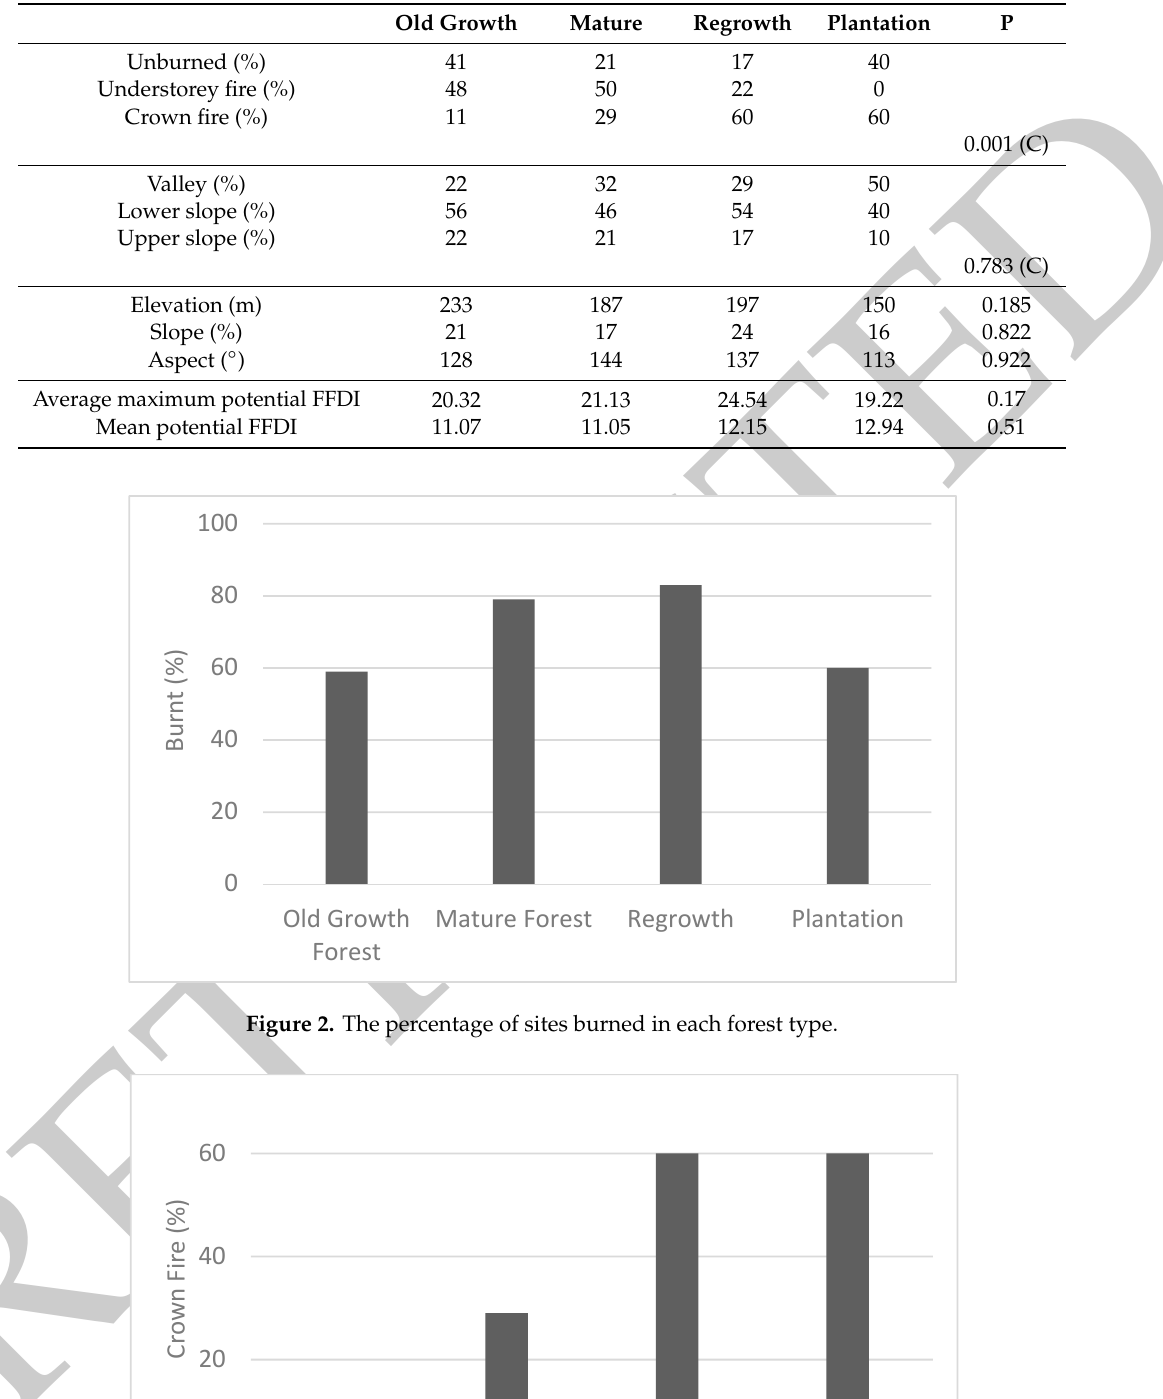
Table 1. Fire severity and environmental conditions by forest type, showing significance of di ff erences (Chi 2 (C) and ANOVA). Column percentages are shown for the Ch i2 analyses.